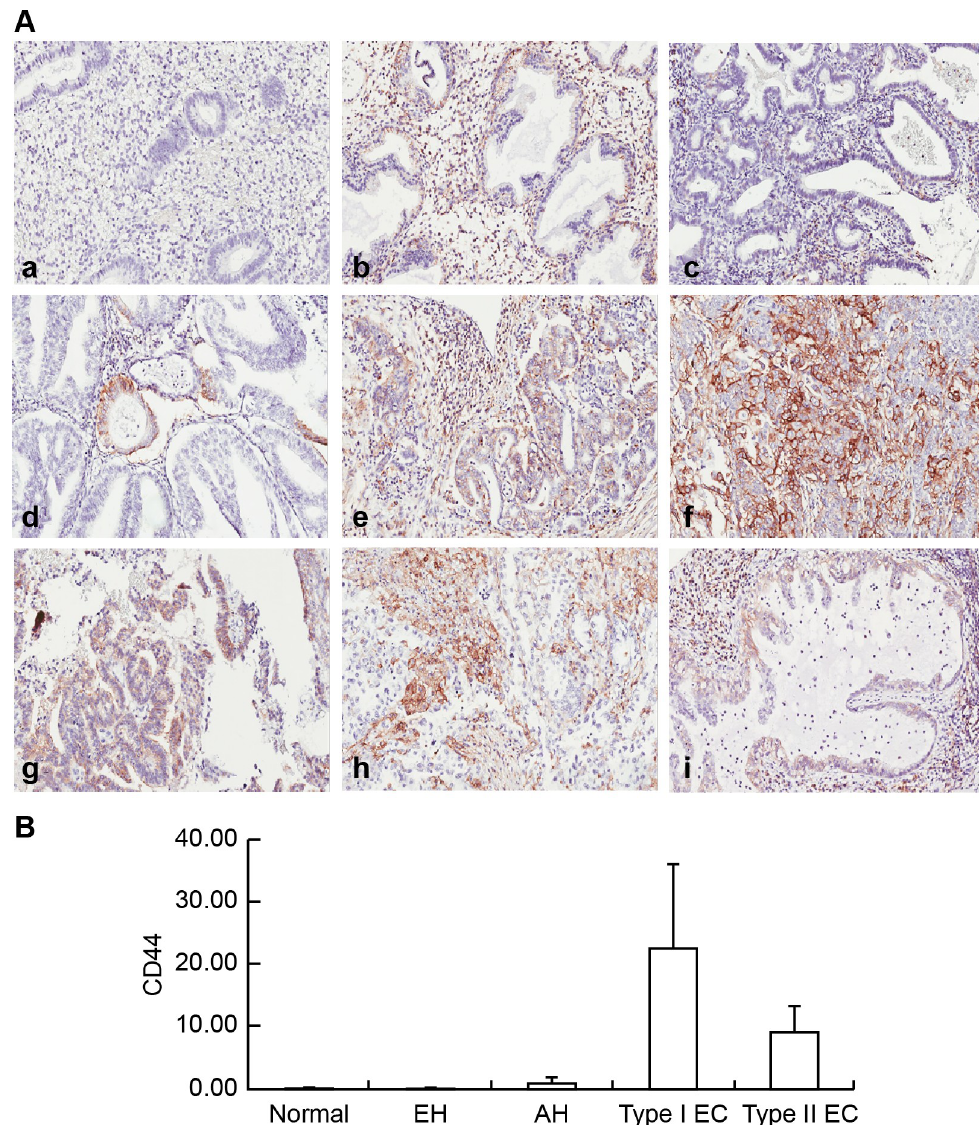
Fig 2. Examples of immunohistochemical staining for CD44 in endometrial lesions. (A) Immunohistochemical examination of CD44 expression in normal endometrium (a), EH without atypia (b), AH(c), grade 1 EmAC (d), grade 2 EmAC (e), G3 EmAC (f), SC (g), CC (h), and MC (i). (B) Semiquantitative Comparison of CD44 Immunostaining Scores Between Normal Endometrium, EH without Atypia, AH, and Type I, and Type II EC. One-way ANOVA, p = 0.229.